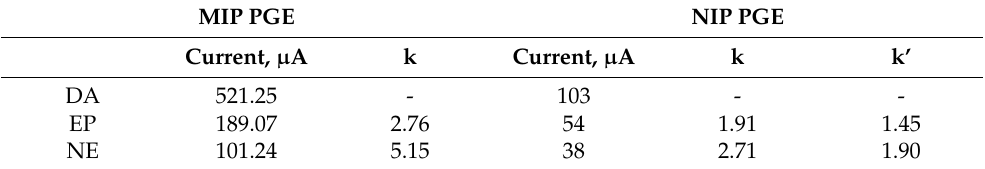
Table 2. Selectivity parameters of the MIP PGE and NIP PGE sensors for 1.32 nM DA. MIP PGE NIP